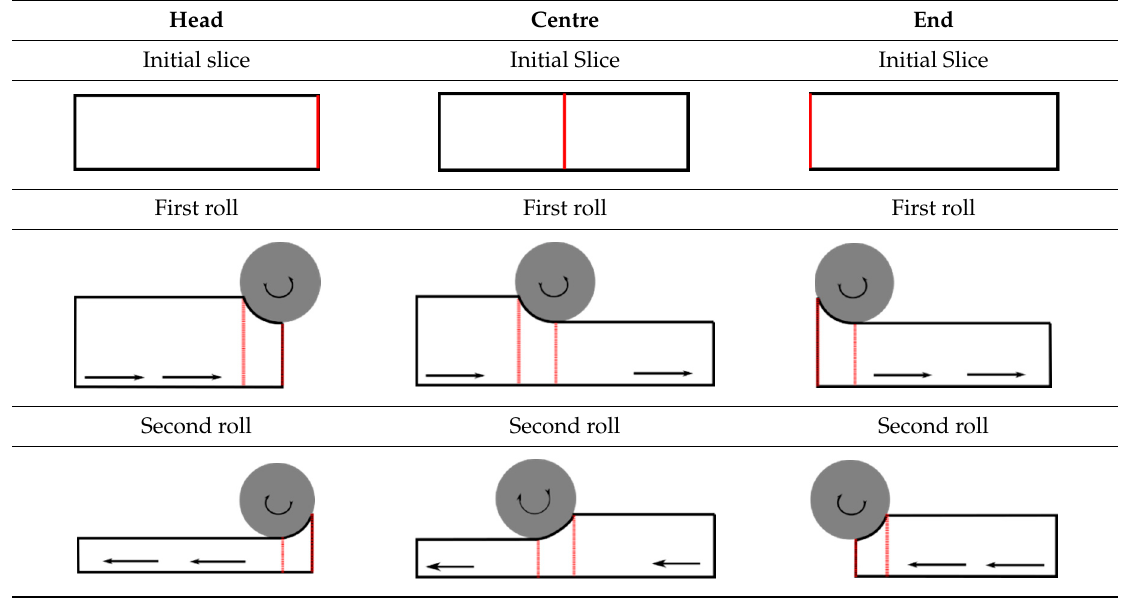
Table 1. Demonstration of computational slice positions during reversing rolling mill simulation.